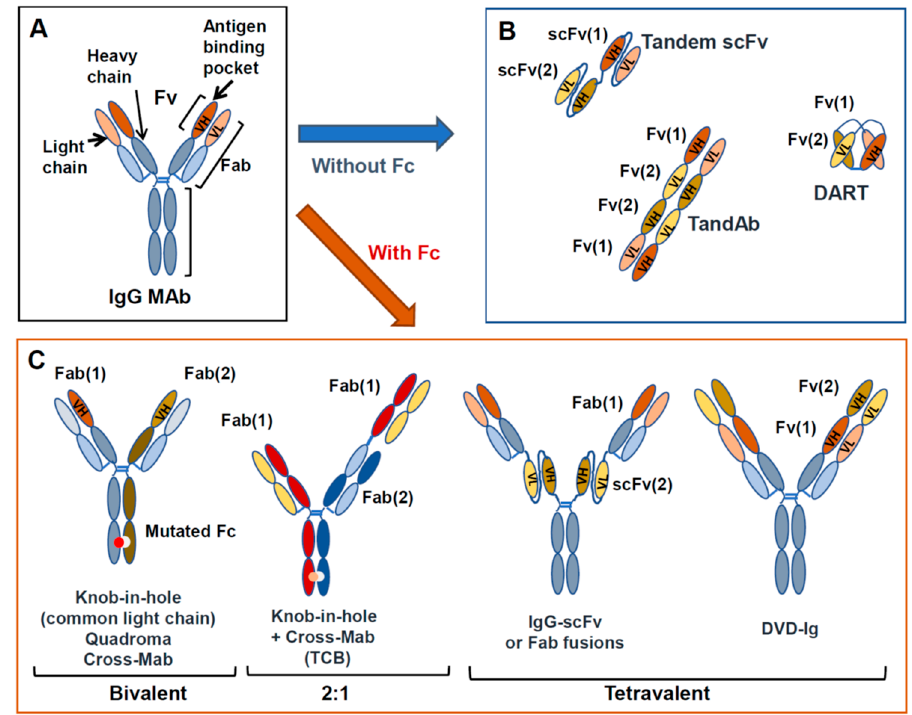
Figure 2. MAb and BsAb structures. Structure of a standard IgG ( A ) and examples of BsAbs, either lacking Fc ( B ) or containing an Fc region ( C ).